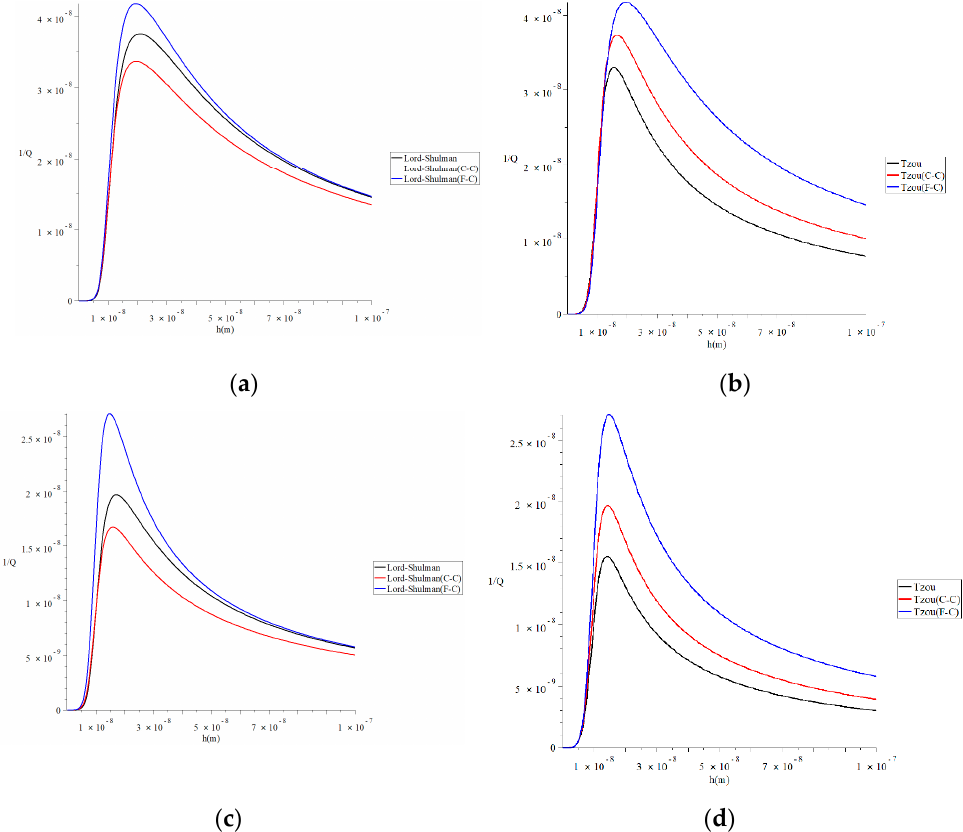
Figure 7. The thermal quality factor for different models with various isothermal values of natural frequency when 40 50 , L = 50 h , b = 4 h , F = 10 − 40 N , and β = 0.6. ( a ) The thermal quality factor for the Lord–Shulman model when q = 4.73/ L ; ( b ) the thermal quality factor for the Tzou model when q = 4.73/ L ; ( c ) the thermal quality factor for the Lord-Shulman model when q = 7.85/ L ; ( d ) the thermal quality factor for the Tzou model when q = 7.85/ L